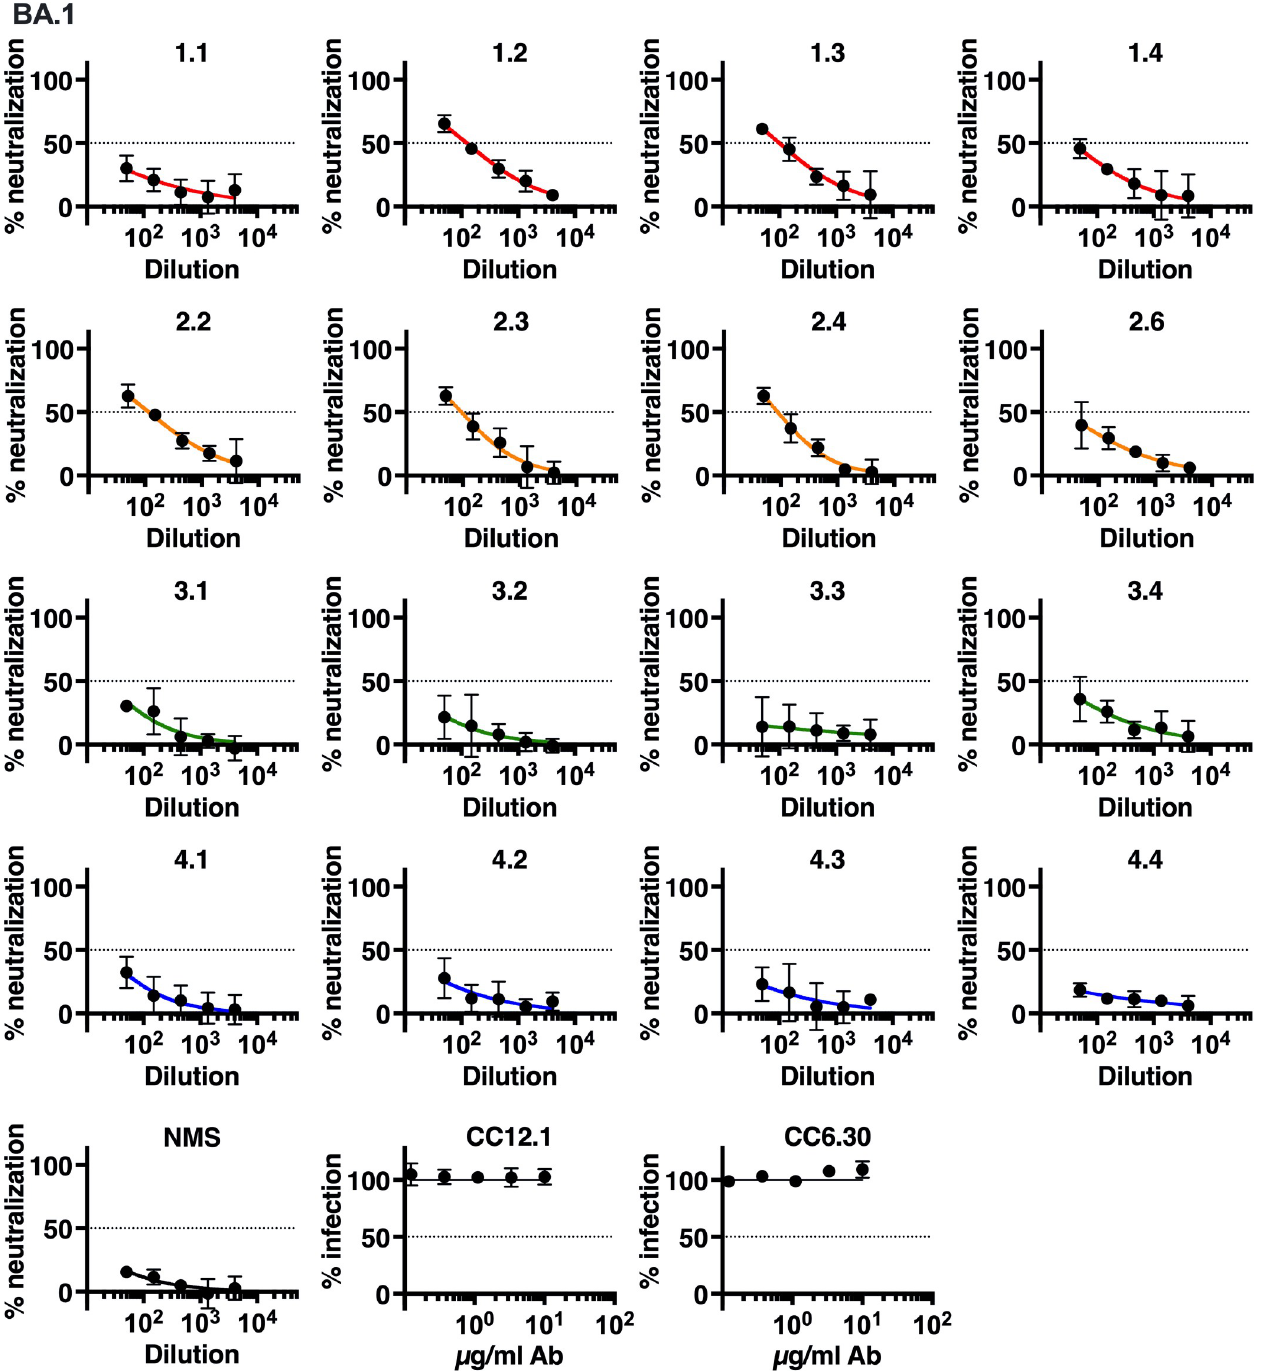
Fig 6. Neutralization of authentic SARS-CoV-2 VOC BA.1/Omicron isolate. Neutralization of authentic SARS-CoV-2 isolate BA.1 by immune sera was measured by focus reduction neutralization test (FRNT) on TMPRSS2-Vero cells. 3-fold serial dilutions started at 1:50. Percent neutralization and percent infection are relative to media-only controls. Data shown are the mean and SD of 4 biological replicates. Dotted lines mark 50% neutralization. Color scheme: red = group 1; orange = group 2; green = group 3; blue = group 4. NMS = normal mouse serum.